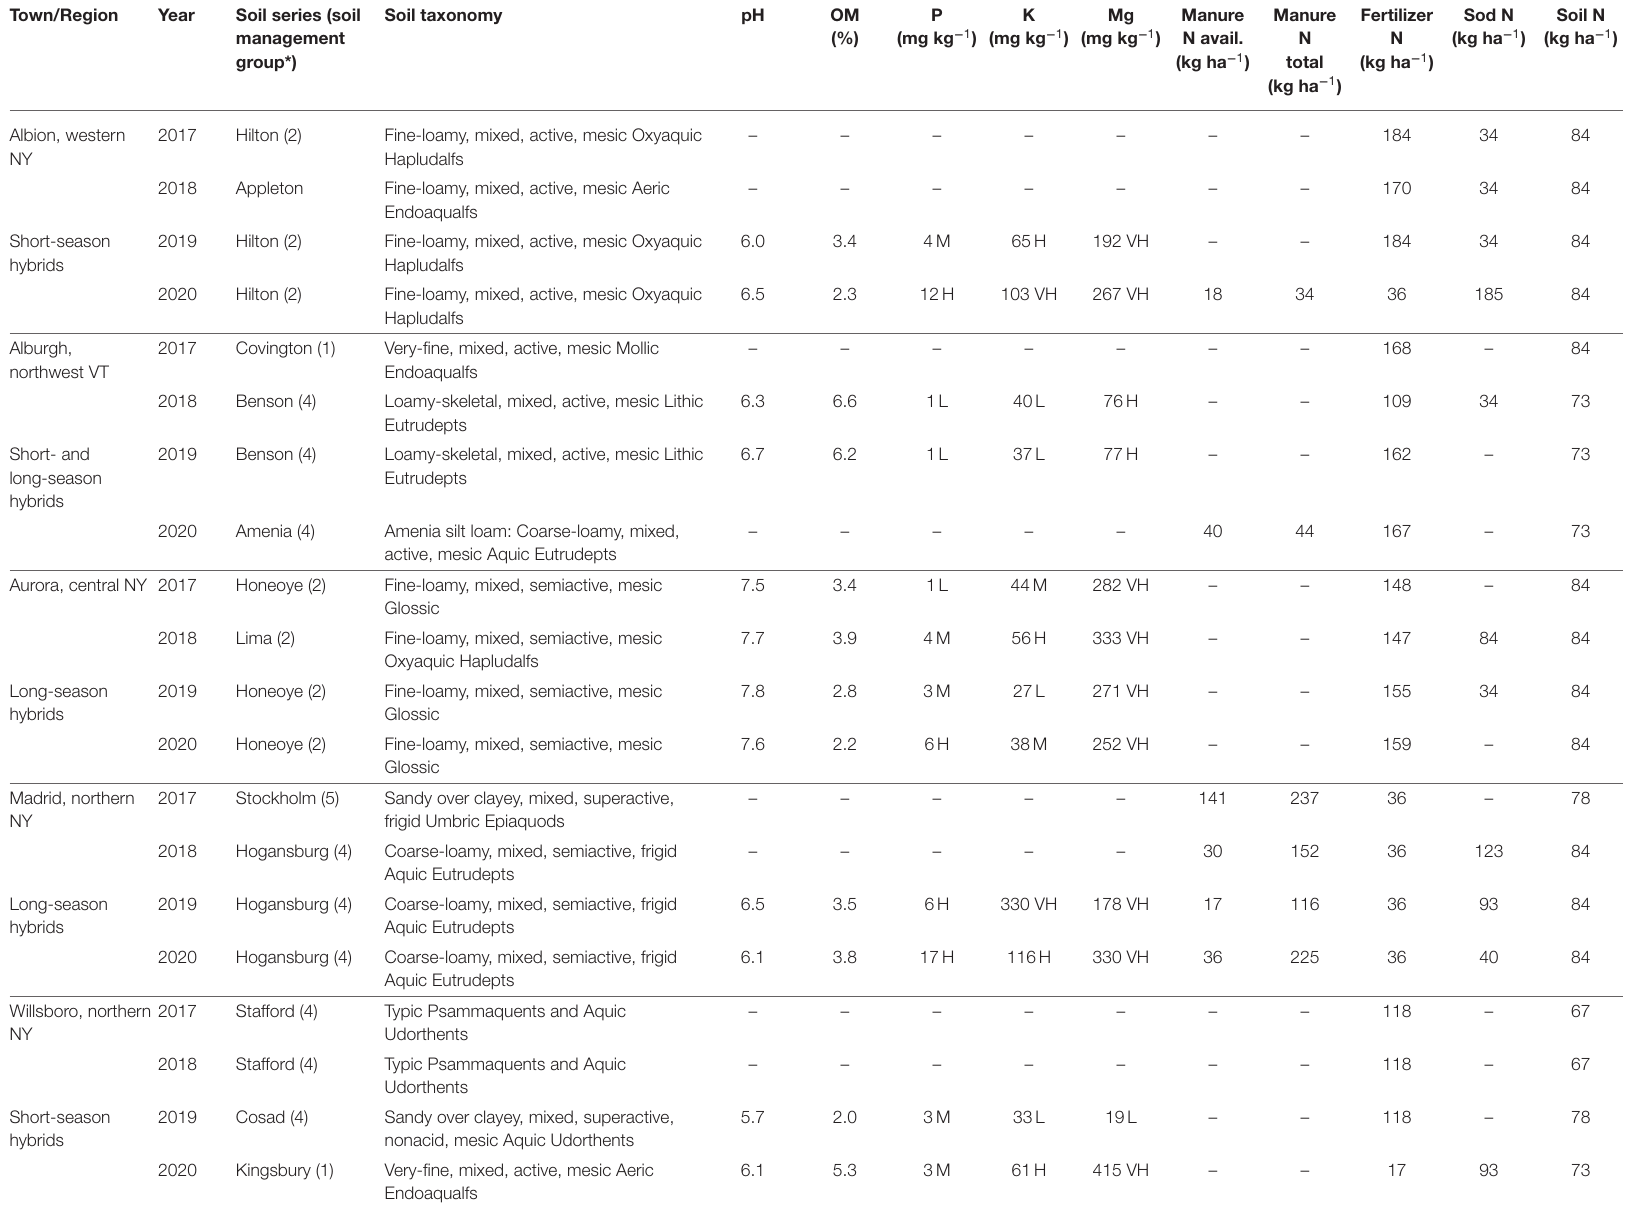
TABLE 1 | Description of each trial location region, soil type, nitrogen fertility management, soil fertility testing, and relative maturity panels present at each trial location.